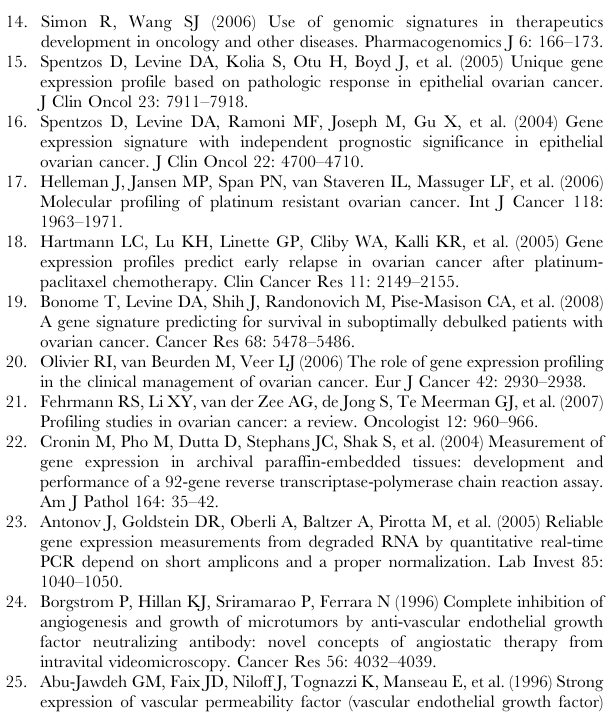
Table S1 Profile genes associated with overall